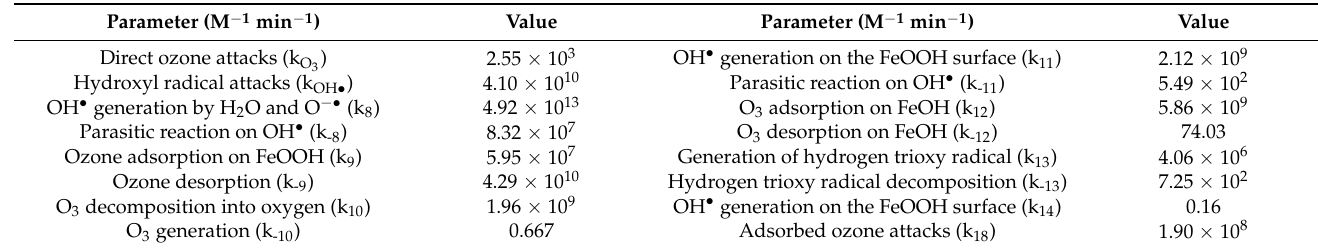
Table 5. Reaction rate constants for the SSA kinetic